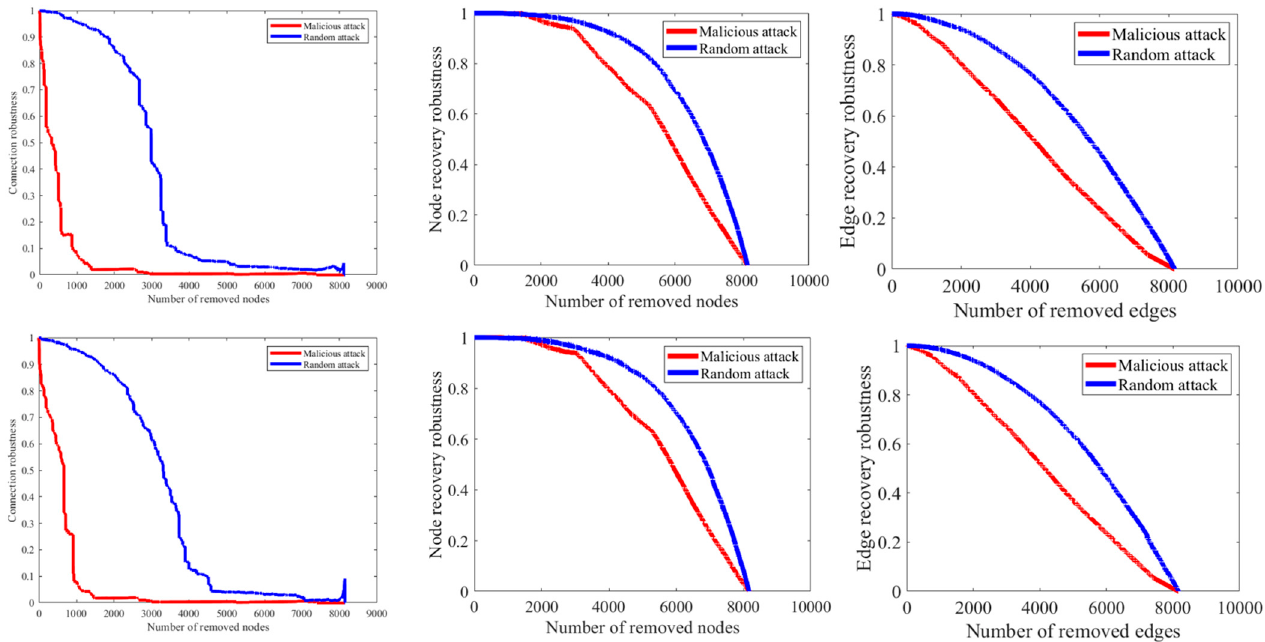
Figure 9. Robustness analysis of network before and after optimization.